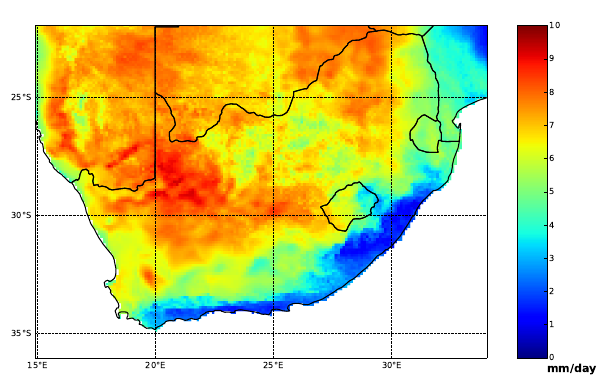
Fig. 5. Daily total of ET 0 computed by summing hourly estimates based on NWP forecast data and LSA-SAF radiation estimates, as in Fig. 4.